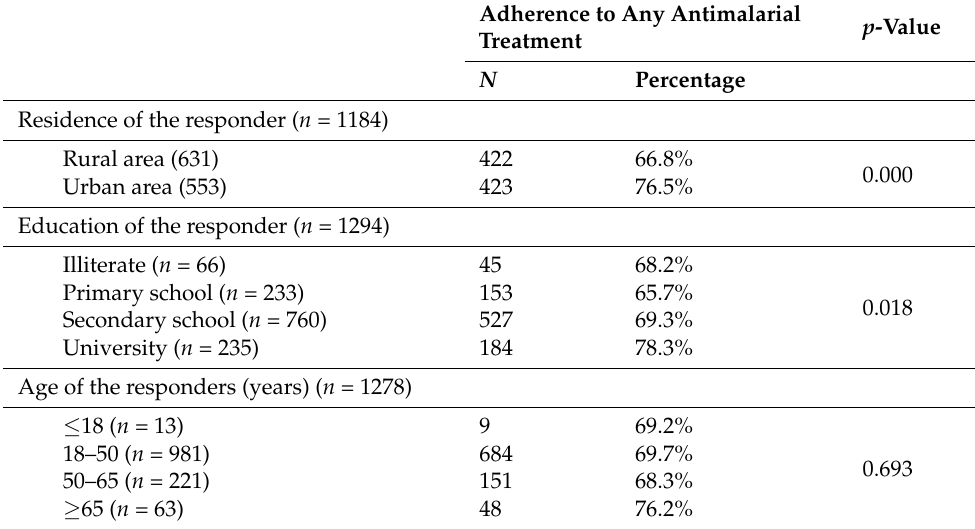
Table 1. Characteristic of the responders and adherence to malaria